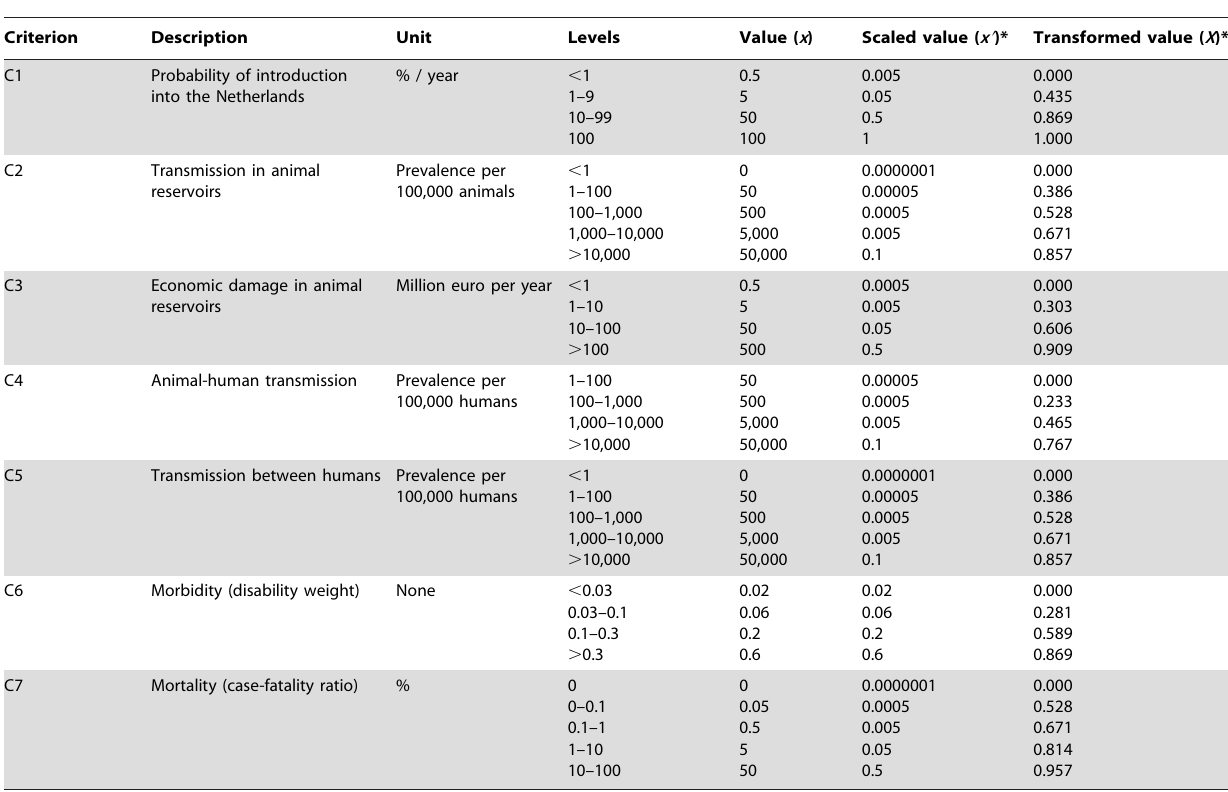
Table 1. Quantifying criteria to assess risk of emerging